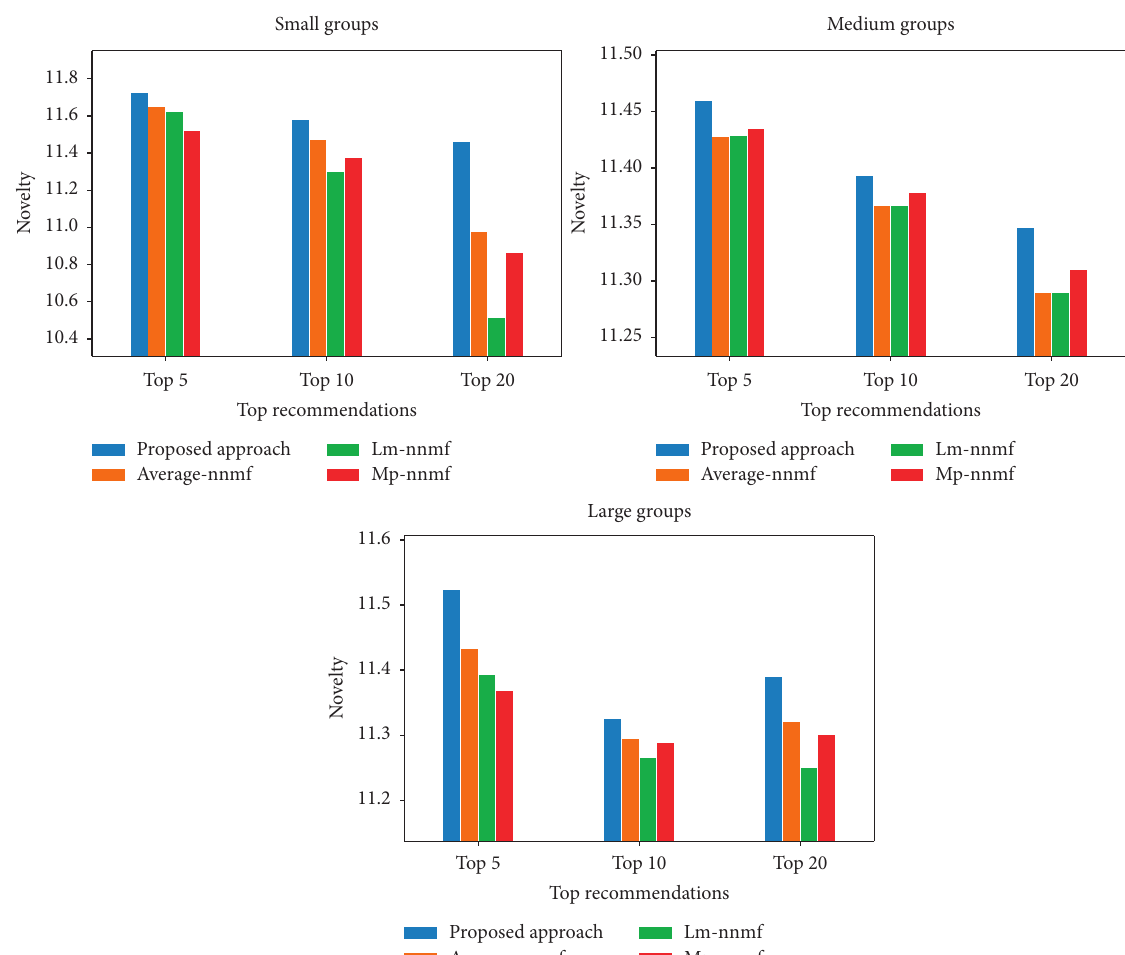
Figure 10: Novelty of the three types of group recommendations